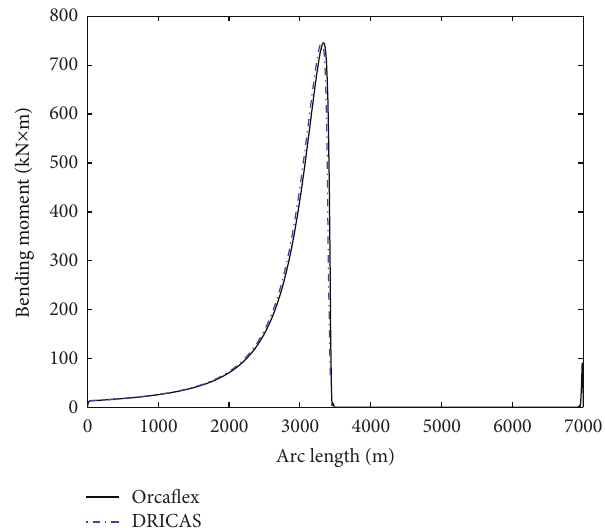
Figure 9: Bending moment result comparison between DRICAS and